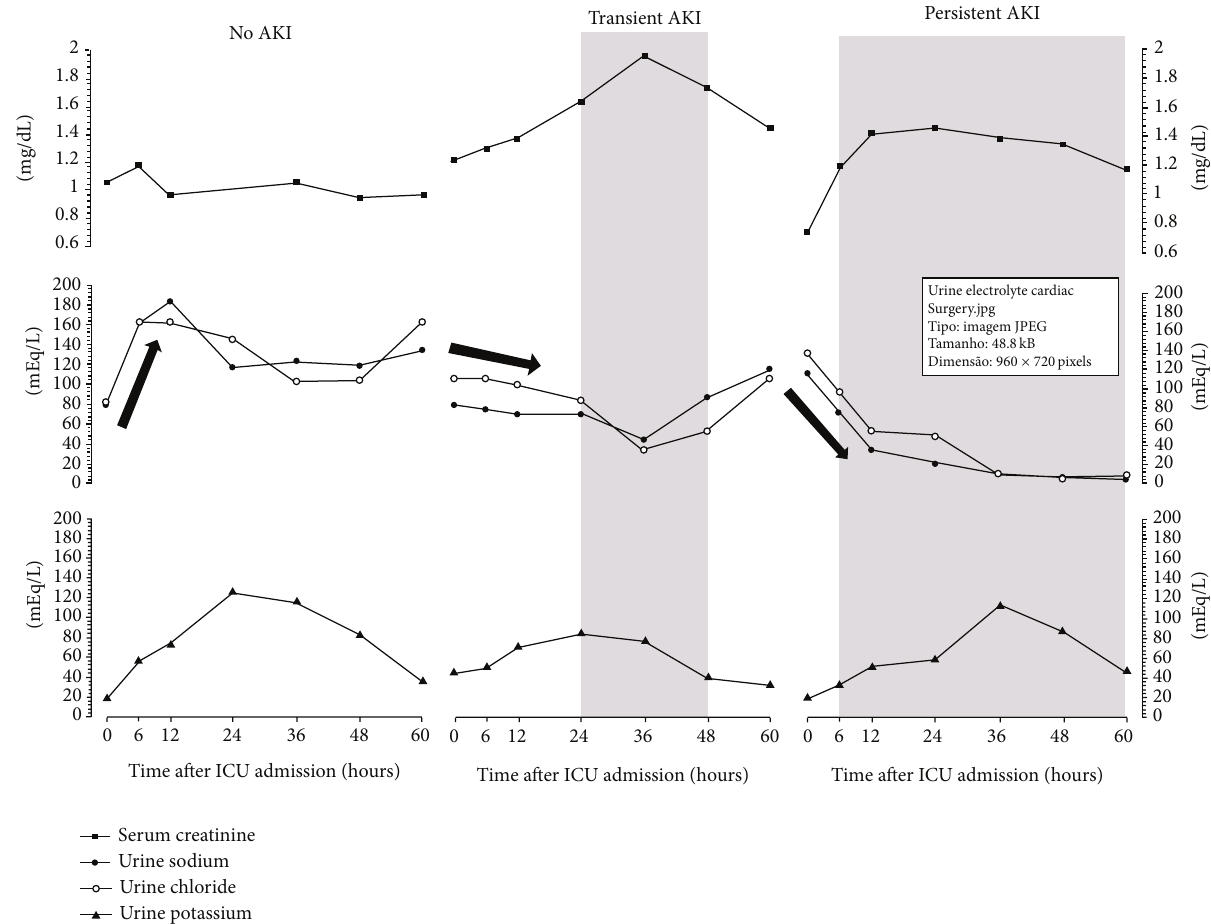
Figure 1: Sequential serum creatinine and urine electrolyte concentrations in the first 60 hours after intensive care unit admission of 3 patients in the postoperative period of cardiac surgery. Patient 1 did not develop creatinine-based AKI (left); patient 2 developed a transient AKI (middle), and patient 3 developed a persistent AKI (right). AKI: acute kidney